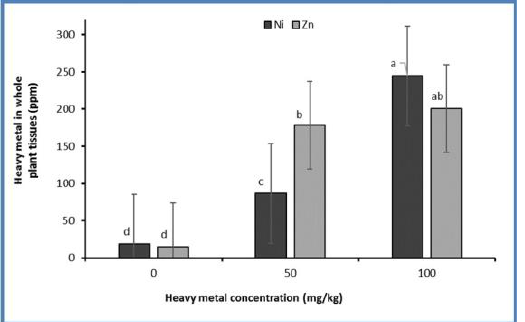
Figure 3. The interaction of element type and concentration in soil on the uptake of heavy metals.